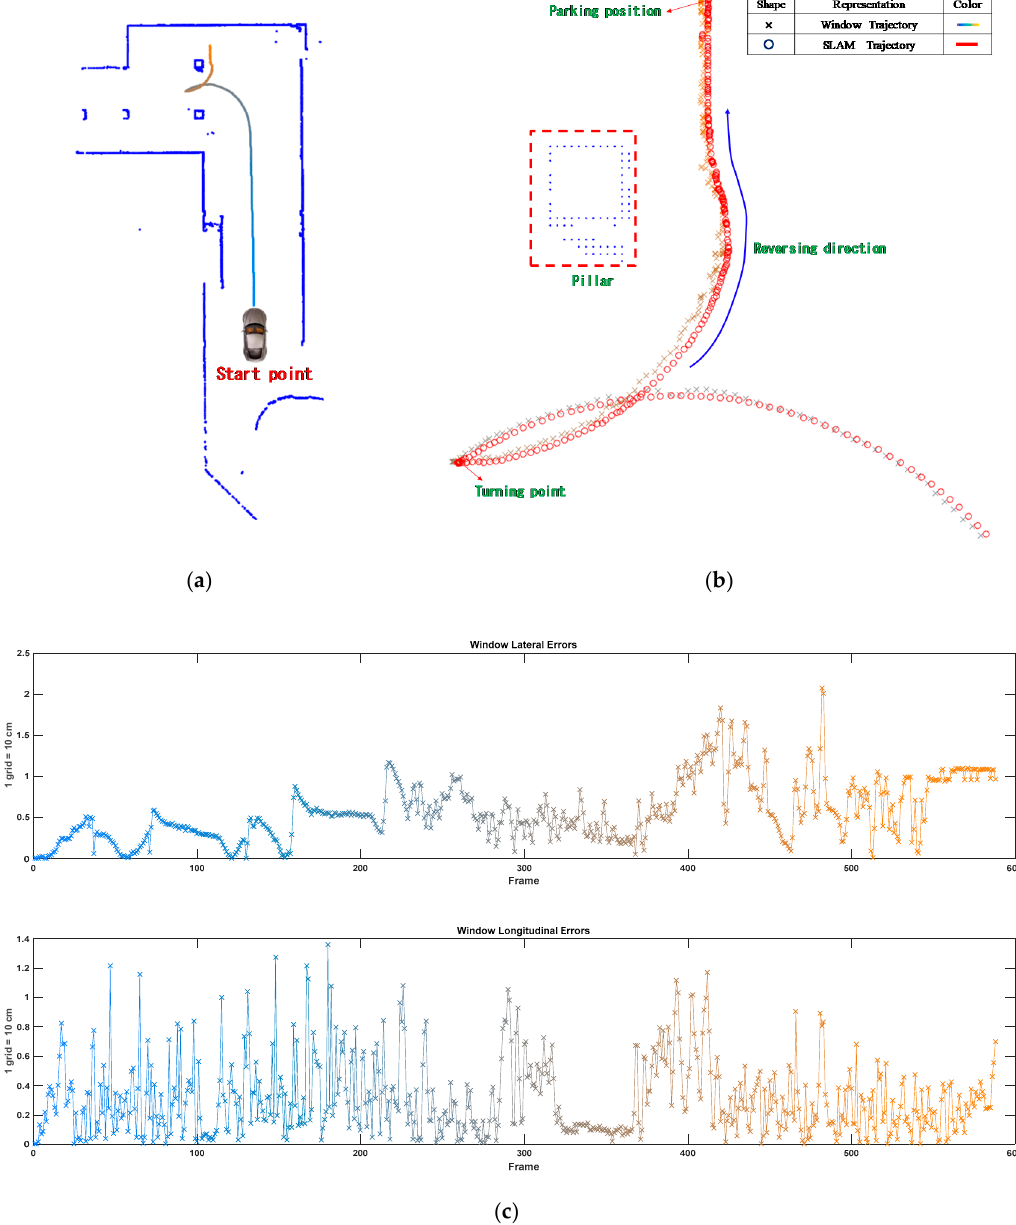
Figure 14. Comparison of the Window and SLAM trajectories. ( a ) Window trajectory. ( b ) Local magnification (when the car was reversing). ( c ) Lateral and longitudinal error comparison between the Window and simultaneous localization and mapping (SLAM) trajectories.